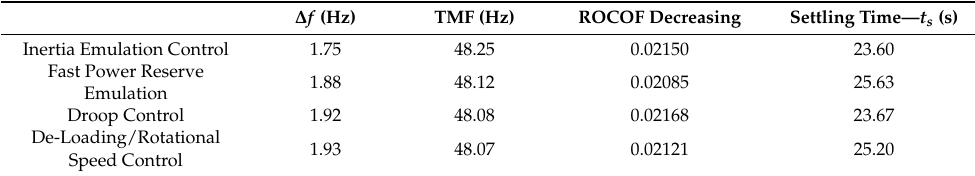
Table 2. Dynamic comparison in low wind speed